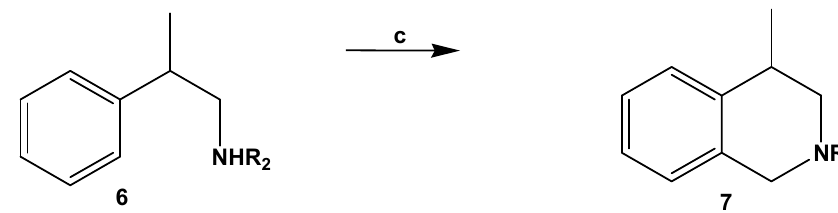
Scheme 4. Synthesis of 4-methyl tetrahydroisoquinolines.